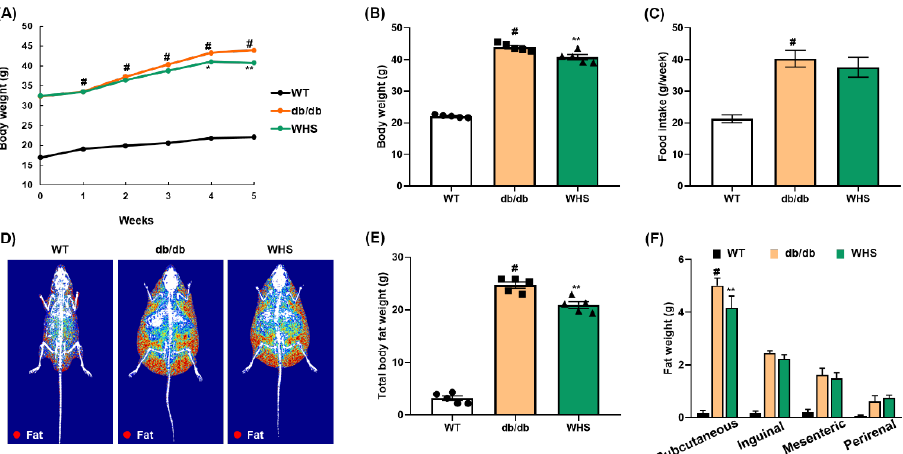
Figure 3. Effect of WHS on the body weight, body fat weight, and food intake of db/db mice. Mice ( n = 5) were treated with vehicle or (WHS 300 mg/kg) for 5 weeks. ( A – C ) Body weight and food intake were measured every week. ( D ) Representative radiographic images of each group of mice analyzed by DEXA. ( E , F ) Total body fat weight and regional white adipose tissue (WAT) weight were measured by necropsy at the end of the experiment. Values are expressed as the mean ± SEM. # p < 0.05 vs. WT control group; * p < 0.05 and ** p < 0.01 vs. db/db control